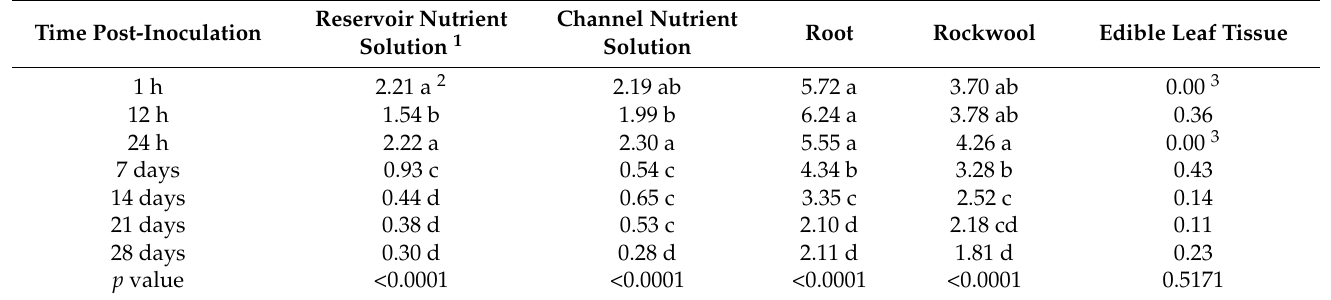
Table 2. Survival of Salmonella enterica serotype Typhimurium (LT2 JSG626) following the